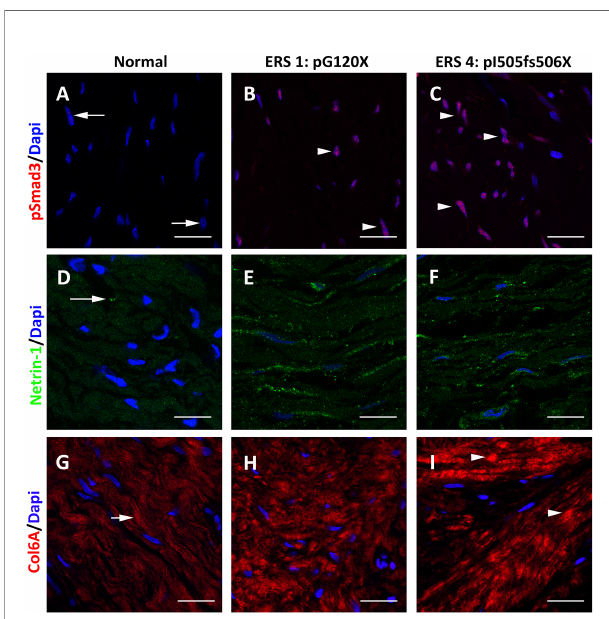
FIGURE 5 | Representative p-SMAD3 staining in gingival tissues from healthy subject (A) and ERS patients (B, C) . (A) A small number of nuclei (arrows) displayed p-SMAD3 immunoreactivity in control gingiva. (B, C) The number of p-SMAD3 immunoreactive nuclei (arrowheads) was dramatically increased in ERS patients. (D) Netrin1 was expressed in discrete spots at fi broblast extremities. (E, F) In ERS patients, Netrin1 immunoreactivty was found in intense spots along the entire fi broblast soma. (G) Fibrous Collagen VI immunoreactivity was found in the Ctl connective tissue (arrow). (H, I) In ERS patients, collagen VI immunoreactivity was increased and expressed along thick and disorganized fi bers. Scale bars: (A – C) , (G – I) : 50 m m; (D – F) : 20 m